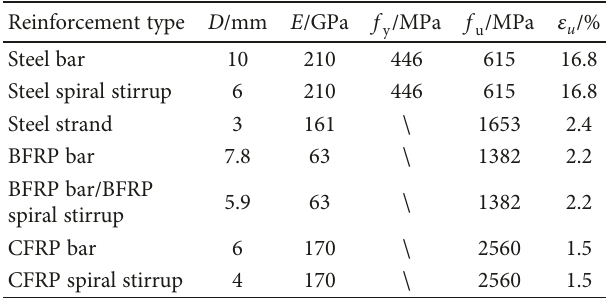
Table 3: Dimensions and mechanical properties of all